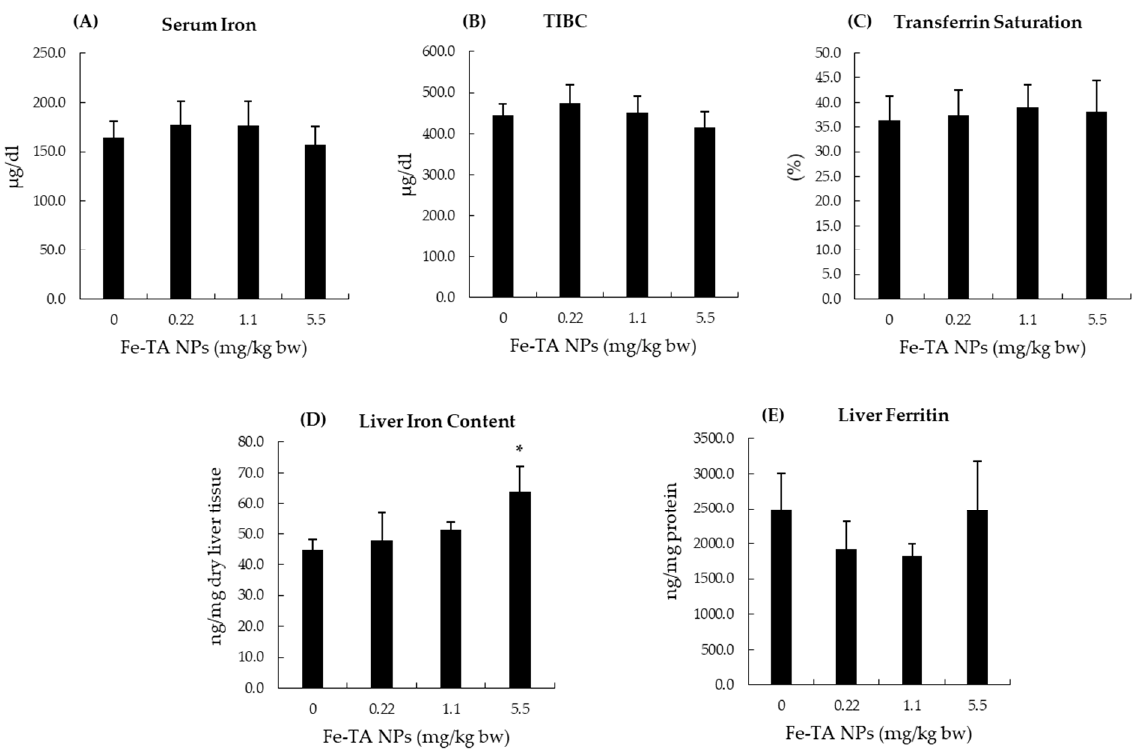
Figure 2. Effect of 28-day experiment of Fe-TA NPs on serum and liver iron parameters in male rats. ( A ): Serum iron, ( B ): TIBC (Total iron binding capacity), ( C ): Transferrin saturation, ( D ): Liver iron content, and ( E ) Liver ferritin. Data are expressed as Mean ± SD. * p < 0.05, significantly different when compared with a control group.